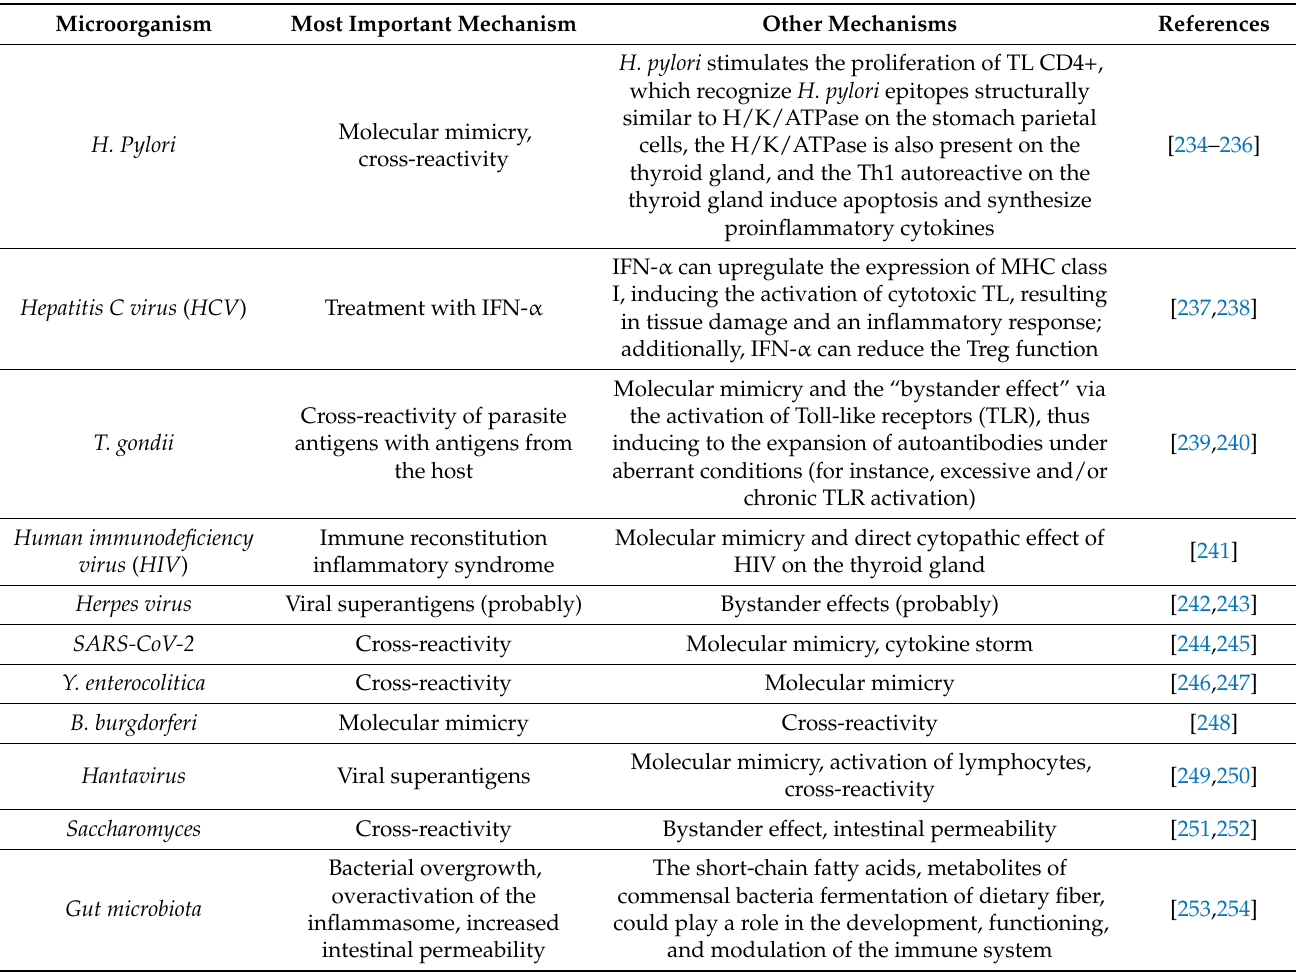
Table 6. Microorganism, gut microbiota, and mechanism involved in AITD.